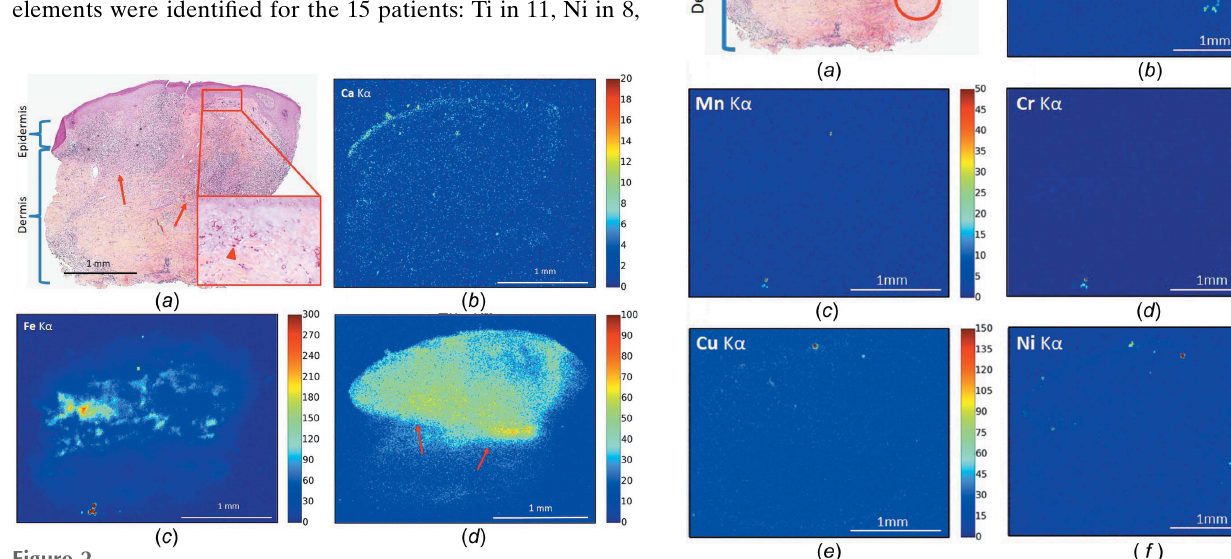
Figure 3 Optical microscopy and XRF maps (patient 2). ( a ) Optical microscopy showing red ink in the superficial and deep dermis and a diffuse inflammatory infiltrate in the upper dermis, HES-stained ( (cid:4) 40). Note the upper extremity of a hair follicle (arrowhead), with a circle indicating the area likely to contain the follicular bulb (not visible on this section). ( b )–( f ) Spatial distribution of Ti, Mn, Cr, Cu and Ni based on the intensity of the XRF K (cid:2) emission. An XRF map was acquired at 10 keV using a 10 m m step size and rapid acquisition (80 ms).